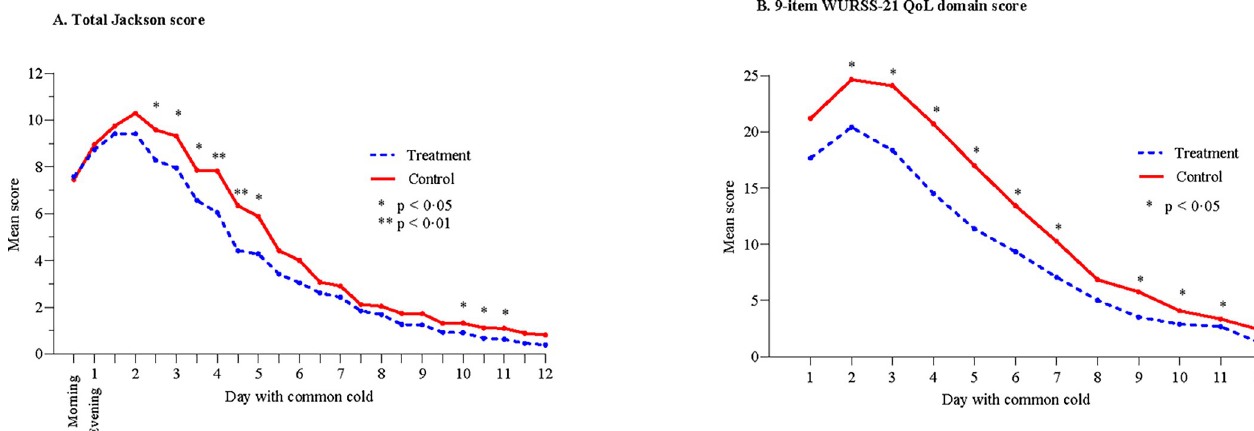
Fig 3. Mean daily sum score over 12 days based on morning and evening values for Jackson score and evening values for the 9-item WURSS-21 QoL domain.